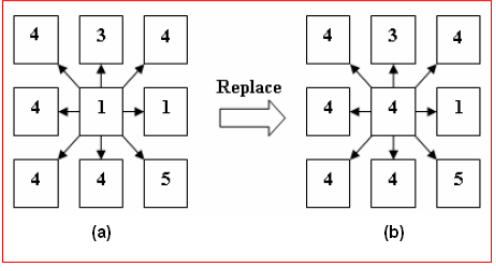
Figure 11. (a) A 3  3 neighborhood before recombination (b) After